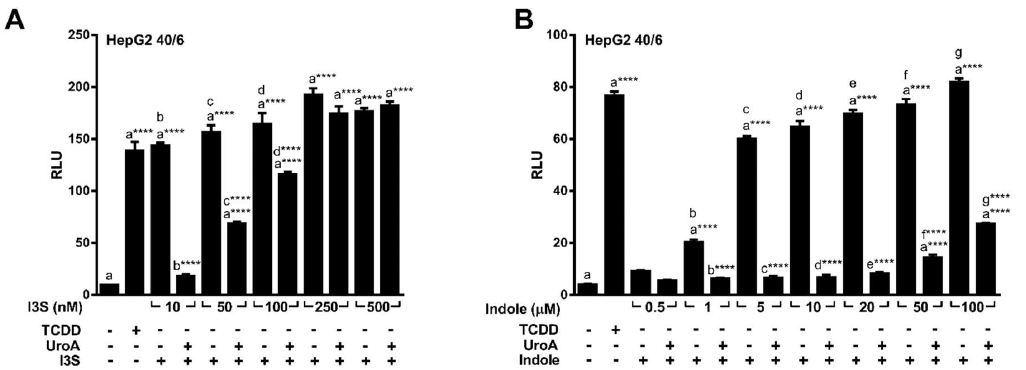
Figure 5. UroA is capable of antagonizing endogenous AHR ligands indole and I3S. HepG2 (40/6) cells were treated for 4 h with 10 µM UroA and indicated doses of ( A ) I3S or ( B ) indole. Cells were lysed, and luciferase activity was measured. Data are presented as mean +/−S.E.M., n = 3; significance was determined by one-way ANOVA, p -value ≤ 0.0001 (****).